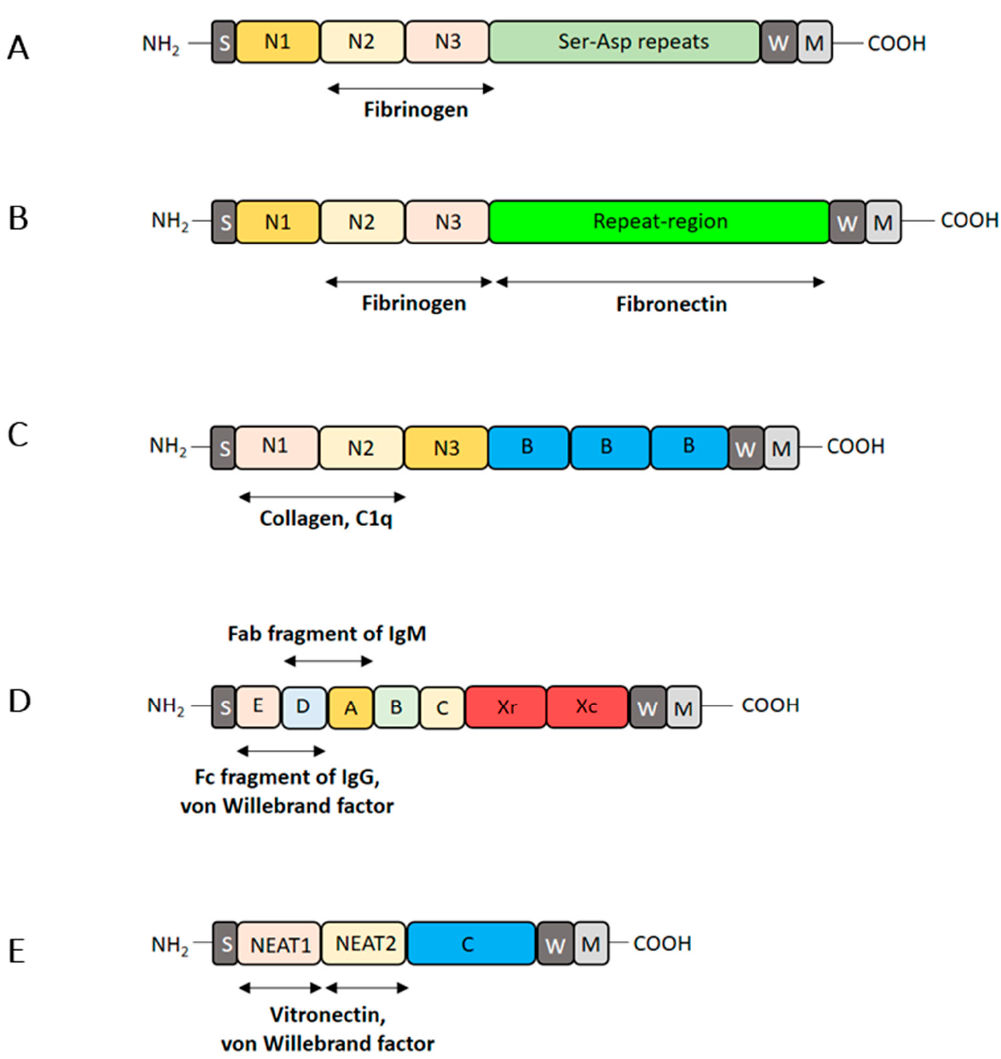
Figure 3. Depiction of S. aureus adhesins. ( A ) ClfA (or ClfB); ( B ) FnBPA (FnBPB); ( C ) CNA; ( D ) SpA; ( E ) IsdB. The N-terminal A region of ClfA, ClfB, FnBPA, FnbpB and CNA contains three separate folded subdomains, named N1, N2 and N3. The serine-aspartate region of ClfA and ClfB is composed of a variable number of serine-aspartate dipeptide repeats. The repeat region of FnBPA and FnBPB comprises 11/10 39-residue fibronectin -binding units. The B region of CNA includes a variable number of B repeats. The Xr and Xc of SpA correspond to repetitive and non-repetitive domains, respectively. All the proteins contain a wall binding region (W) and a membrane spanning region (M) at the C-terminus. For each adhesin the binding sites for specific host proteins are indicated.